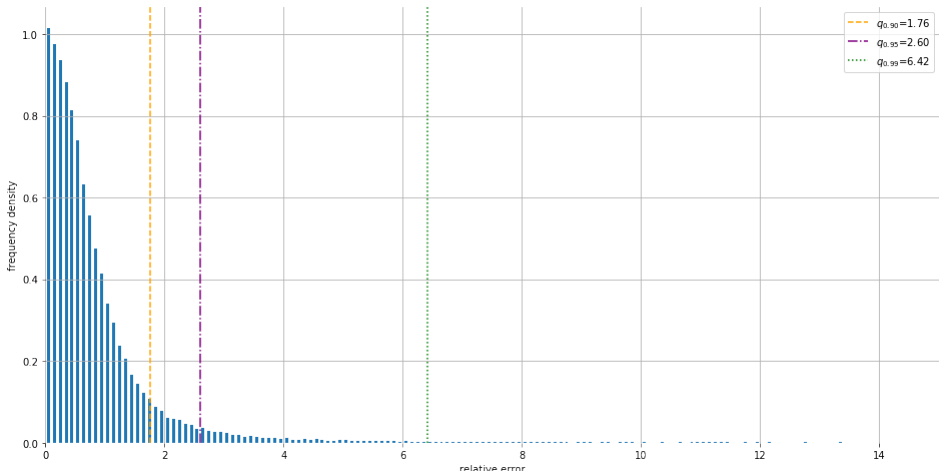
Figure 8. Normalized histogram of RE on test set with quantiles.